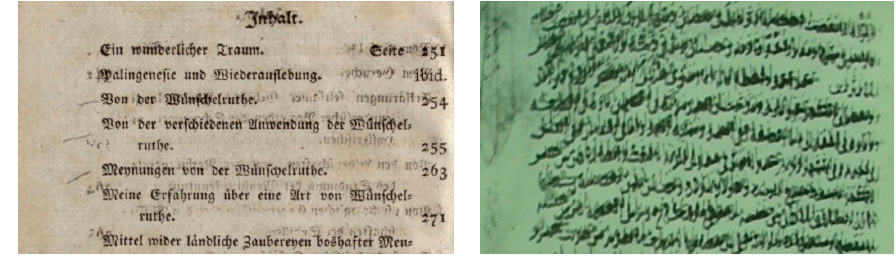
Figure 8. Example showing degraded document with blurring effect.